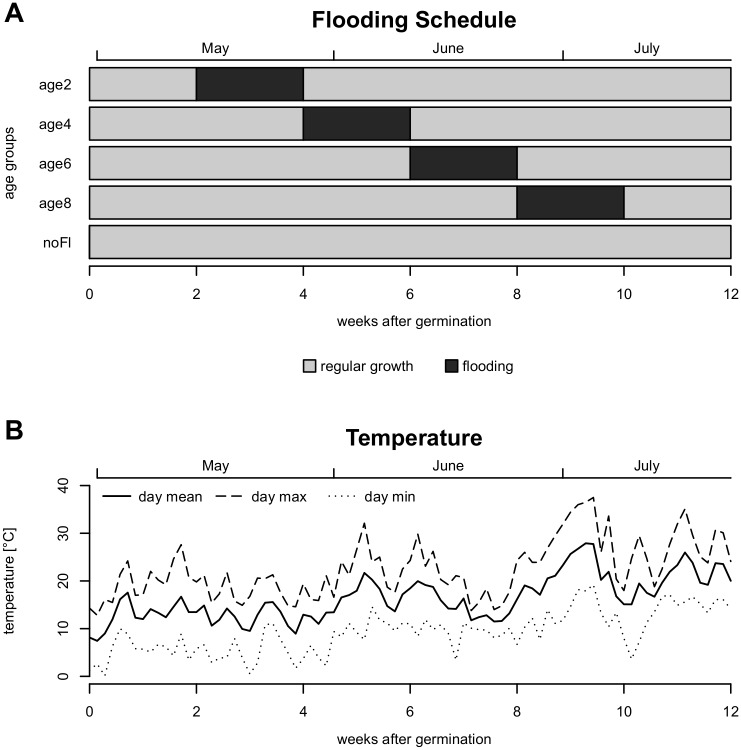
Time schedule and air temperatures for the flooding experiment of four floodplain meadow species.(A) Time schedule of age groups: four age groups with a 2-week flooding treatment starting 2, 4, 6, and 8 weeks after germination (age2, age4, age6, age8) and one unflooded control group (noFl) with regular growth through 12 weeks. (B) Temperature trend during time of the experiment (solid line: daily mean temperature, dashed line: daily minimum temperature, dotted line: daily maximum temperature). Temperature data from HLNUG (Hessian Agency for Nature Conservation, Environment and Geology, http://www.hlnug.de), weather station Linden (distance from experimental site: 700 m).